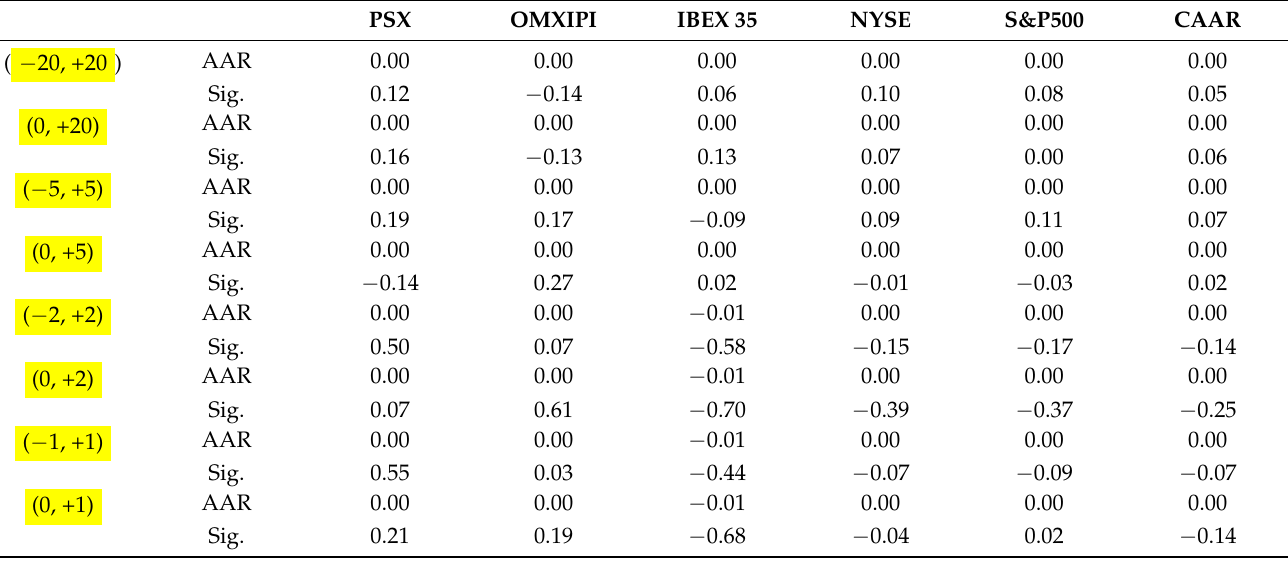
Table A20. Average abnormal return and cumulative abnormal return (Prime Minister of Iceland announced his